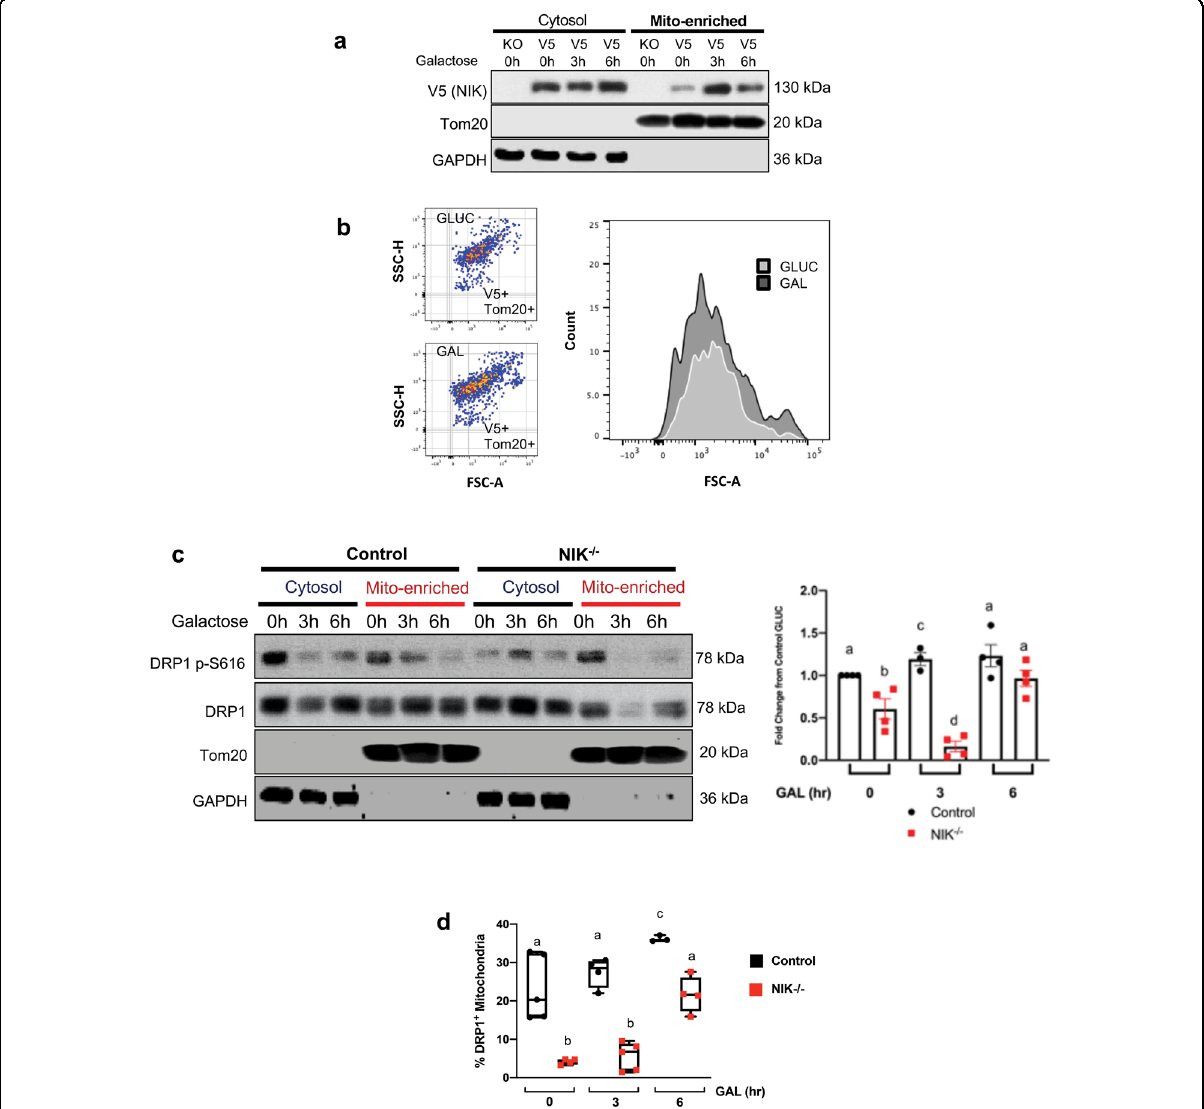
Fig. 3 Forced reliance on OXPHOS increases mitochondrial accumulation of NIK. a Representative immunoblot analysis of cytosolic and mitochondrial subcellular fractions in BT25 NIK − / − cells reconstituted with NIK conjugated to V5 tag (NIK-V5) after metabolic switch from glucose to galactose media was performed with indicated antibodies. b Representative single organelle fl ow cytometry analysis was performed on BT25 NIK-V5 cells cultured in 18 mM glucose (top left) or 18 mM galactose (bottom left) and immunostaining with mitochondrial Tom20 (AF488) and V5 (AF647). (Right) histogram demonstrating the increase in NIK-V5 + mitochondria upon switch to 18 mM galactose media for 6 h. Individual mitochondria analyzed for glucose conditions n = 20,268 and individual mitochondria for galactose conditions, n = 20,242. c Immunoblot analysis was performed with indicated antibodies using cytosolic and mitochondrial subcellular fractions from BT25 control and NIK − / − cells shifted from glucose to galactose at the indicated times (left). Quanti fi cation of n = 3 – 4 independent biological replicates of total DRP1 western blot by densitometry analysis in Image J shown in c . Individual Student ’ s t tests were performed between conditions. Different letters indicate statistically signi fi cant differences; “ a vs b ” , “ a vs c ” , “ b vs c ” , and “ b vs d ” p < 0.05; “ a vs d ” p < 0.001 and “ c vs d ” p < 0.0001. d Single organelle fl ow cytometry analysis of DRP1-AF488 recruitment at MitoSox ™ Red + mitochondria. Each cell/condition was compared to DRP1 − / − as a negative control to determine the level of mitochondria enrichment. Individual Student ’ s t tests were performed between conditions. Different letters indicate statistically signi fi cant differences; “ a vs b ” and “ b vs c ” p < 0.0001, “ a vs c ” p <